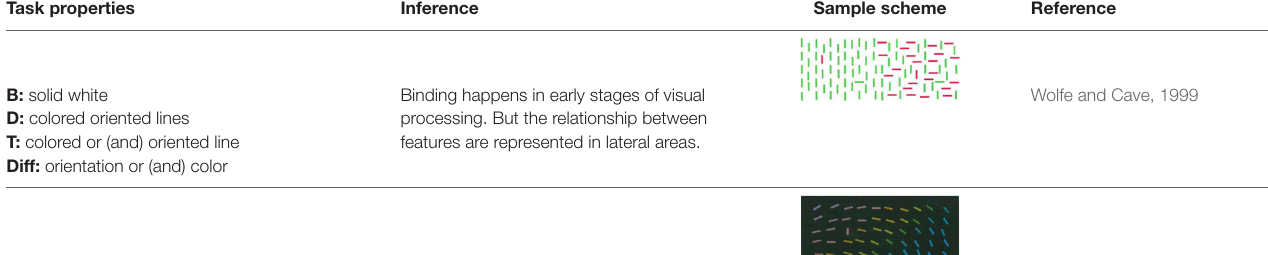
TABLE 2 | An overview of common visual search experiments. Task properties Inference Sample scheme